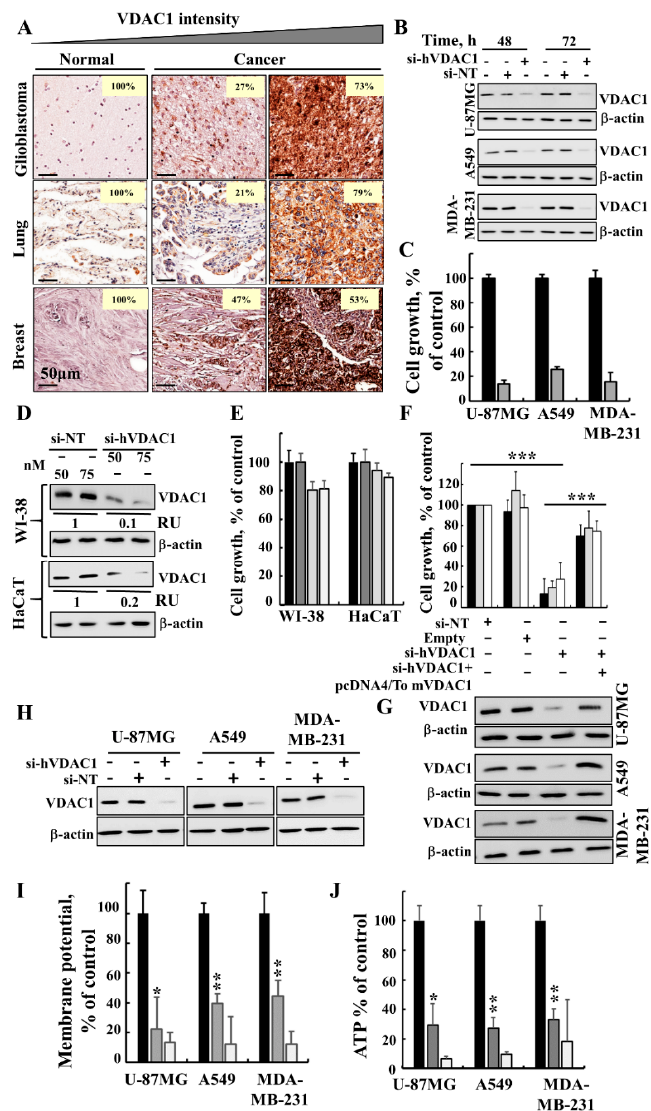
Figure 1. si-hVDAC1 treatment silences VDAC1 expression, causes cell growth inhibition and reduces energy production. ( A ) IHC staining of VDAC1 in sections derived from human normal tissue ( n = 13), glioblastoma ( n = 40), lung cancer ( n = 20) and breast cancer ( n = 20) in tissue microarray slides (Biomax). Percentages of sections stained at the indicated intensity are shown. ( B , C ) U-87MG, A549 and MDA-MB-231 cells were treated with 50 nM si-NT (black bars) or si-hVDAC1 (grey bars) and 72 h post-treatment were analysed for VDAC1 levels by immunoblotting ( B ) and cell growth using the SRB assay (mean ± SEM; n = 3) ( C ). ( D , E ) WI-38 and HaCaT cells treated with si-NT (50 or 75 nM, black and grey bars, respectively) or si-hVDAC1 (50 or 75 nM, light grey and white bars, respectively) and analysed for VDAC1 levels by immunoblotting 48 h post-transfection (RU indicates relative value) ( D ) and for cell growth using the SRB assay (mean ± SEM; n = 3) ( E ). F , G ) U-87MG (black bars), A549 (light grey bars) and MDA-MB-231 cells (white bars) were transfected with si-NT or si-hVDAC1 (50 nM) and 24 h post-transfection, the cells were again transfected with plasmid pcDNA4/TO, either empty or encoding mVDAC1. After 24 h, cell growth was analysed by the SRB method (mean ± SEM; n = 3) ( F ) or analysed for VDAC1 levels by immunoblotting ( G ). ( H – J ) Immunoblot ( H ), mitochondrial membrane potential ( ∆Ψ ) ( I ) and ATP ( J ) levels were analysed in U-87MG, A549 and MDA-MB-231 cells treated with 50 nM si-NT (black bars) or si-hVDAC1 (grey bars). Cells treated with FCCP, (25 µ M) (white bars) served as controls for decreasing ∆Ψ and ATP levels. β -actin served as an internal loading control. Mean ± SEM; n = 3; * p ≤ 0.05; ** p ≤ 0.01; *** p ≤